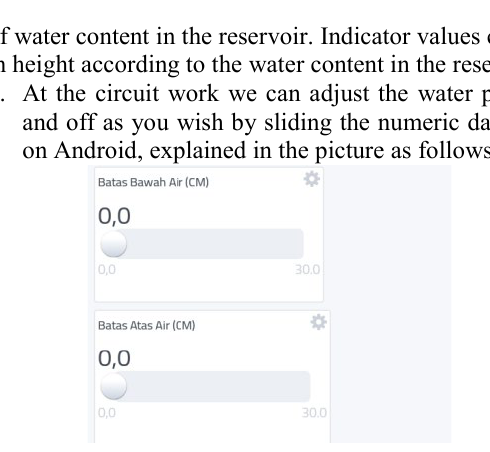
Figure 18. Pump Setpoint ON and OFF In figure 18. explained for the lower limit of water